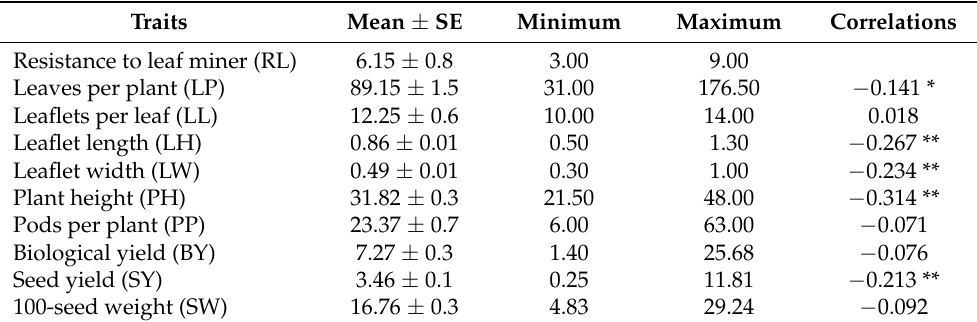
Table 2. Means, standard errors (SE) and ranges for resistance to the leafminer and agro- morphological traits, and correlations between RL and agro-morphological traits in RILs derived from interspecific crosses between C. arietinum and C.